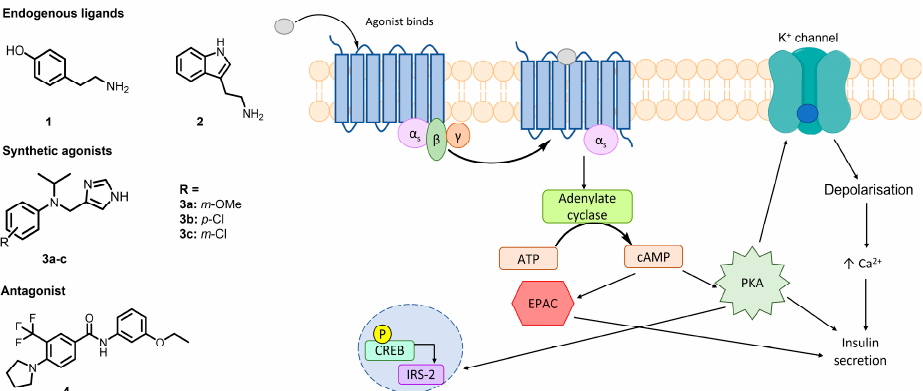
Figure 12. Structures of TAAR1 ligands (1–4) and the proposed therapeutic effects of activated pancreatic TAAR1. ATP; adenosine triphosphate, cAMP; cyclic adenosine monophosphate, EPAC; exchange proteins activated by cAMP, PKA; protein kinase A, CREB; cAMP response element-binding protein, IRS-2; insulin receptor substrate-2.